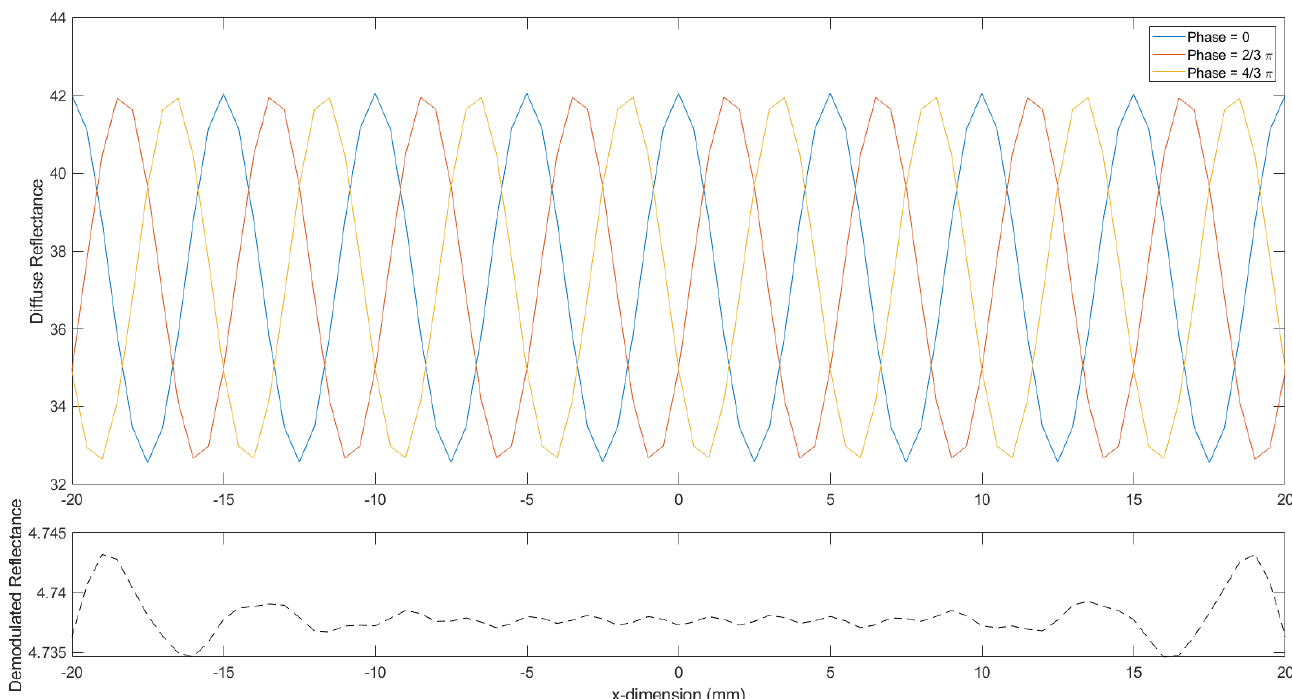
Figure 3. AC pattern and demodulation line profiles. Line profiles across the center on the white bounding box for the three phases at f x = 0.2 mm −1 alongside the AC demodulated profile of the same region. Here, the AC demodulation exhibits less than 0.2% variation across the full profile.